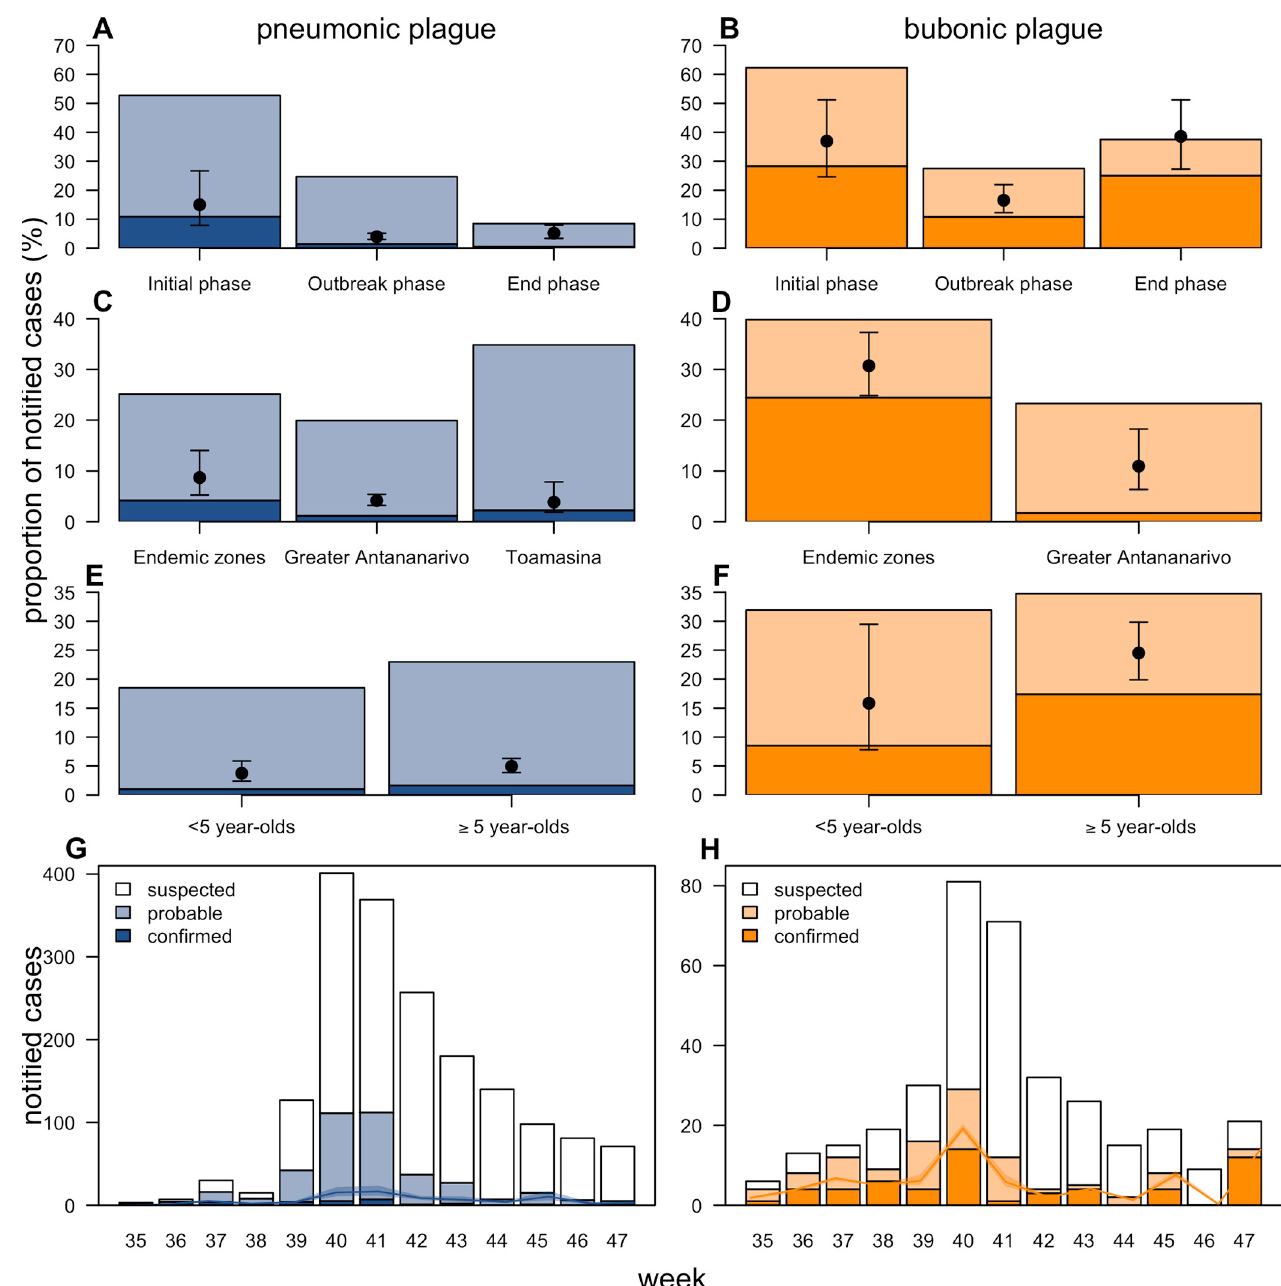
Fig 5. Reconstruction of the outbreak by place and time. (A, B) Estimated prevalence of infection among notified cases by time period for PP (A) and BP (B). Here, the initial phase spans weeks 34–38, outbreak phase 39–43, and the end phase 44–48. (C, D) Prevalence estimates by zone for PP (C) and BP (D). No BP cases were notified from Toamasina. (E, F) Prevalence estimates by age for PP (E) and BP (F). (G, H) Observed notifications (bars) vs. estimated infections (solid lines with shading denoting 95% credible intervals) among notified cases for PP (G) and BP (H). The stacked bar plots denote the percentage (A–F) and absolute numbers (G–H) by case classification. The underlying data and code to reproduce this figure are available on Open Science Framework (https://osf.io/ nbc4t/). BP, bubonic plague; PP, pneumonic